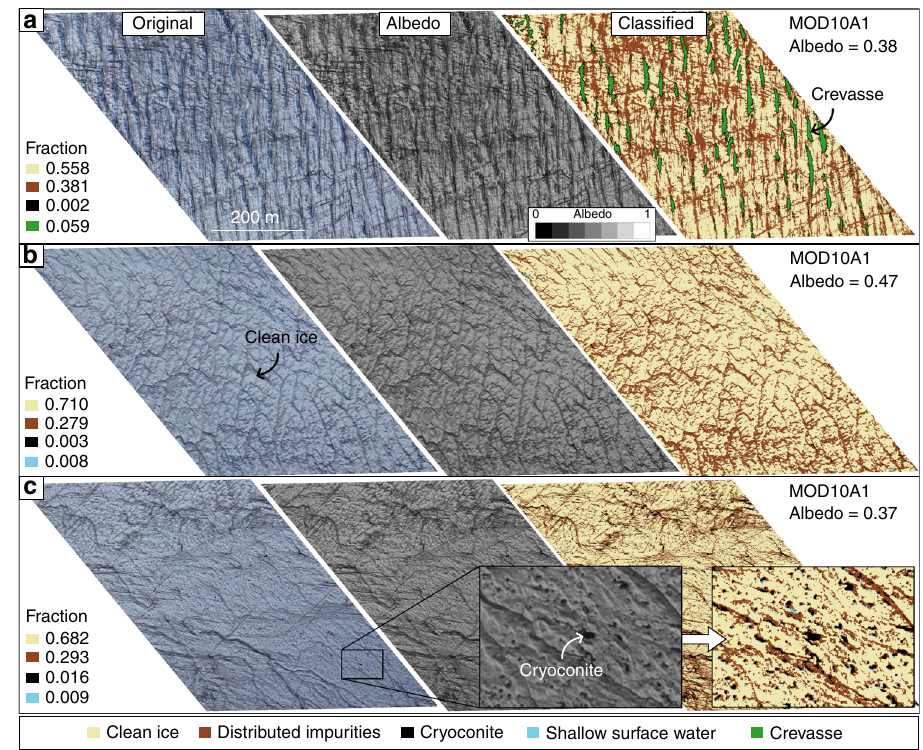
Fig. 6 RGB digital image, albedo map and classi fi cation of surface types in three more MOD10A1 pixels. The albedo maps were derived from the digital images (Methods). The locations of the segments along the UAV transect are shown in Fig. 1. a Segment containing a high fraction of crevasses. b Segment characterized by a much lower relief surface and no crevasses. c Segment characterized by clean ice and numerous cryoconite